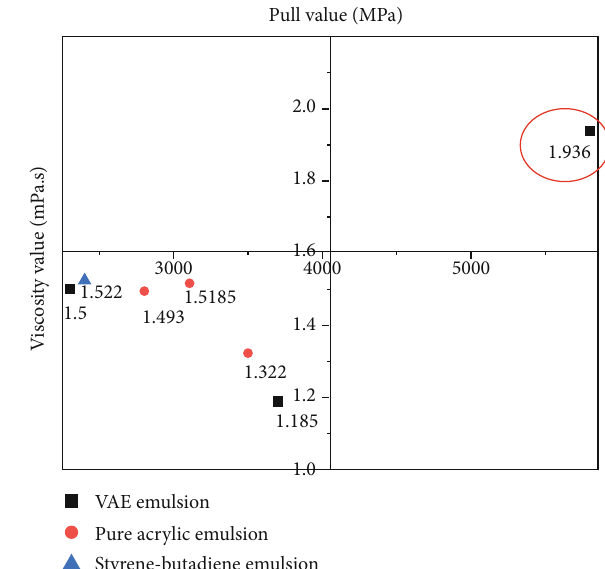
Figure 14: Scatter distribution of bending and compression data.